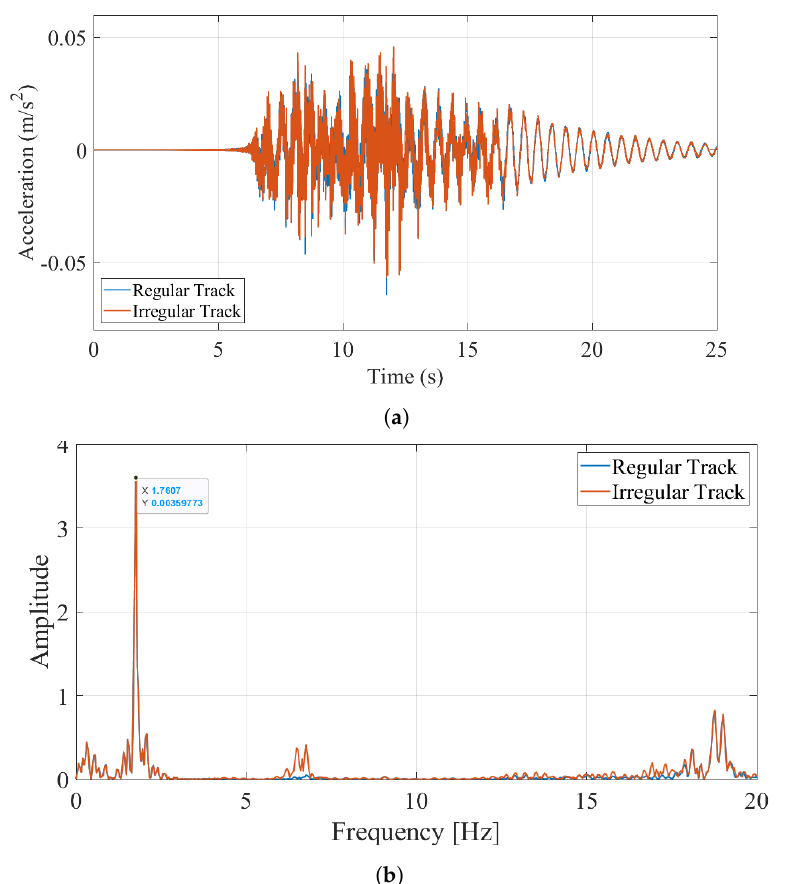
Figure 9. ( a ) Acceleration time history recorded at the x = 8.1 m on the bridge ( b ) Fourier Amplitude Spectrum of the recorded accelerations 20 km/h.